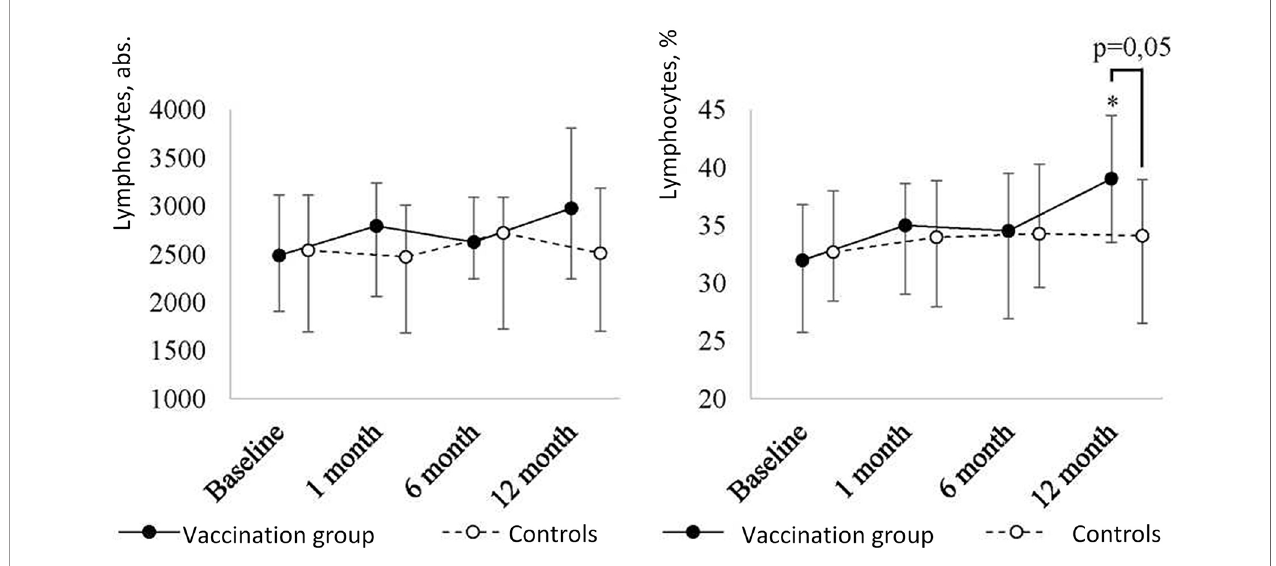
FIGURE 2A | Peripheral blood lymphocyte level dynamics in children with a history of solid tumors in the study group (after revaccination with the ADS-m toxoid, n = 26) and the control group (n = 15), the median and the interquartile range are shown [Me (Q1-Q3)]. *statistically signi fi cantly different from the pre-vaccination value (p ≤ 0.05). To analyze alterations, the post-hoc Demsar test was used with a statistically signi fi cant Friedman omnibus test. Study groups were compared with the Mann-Whitney